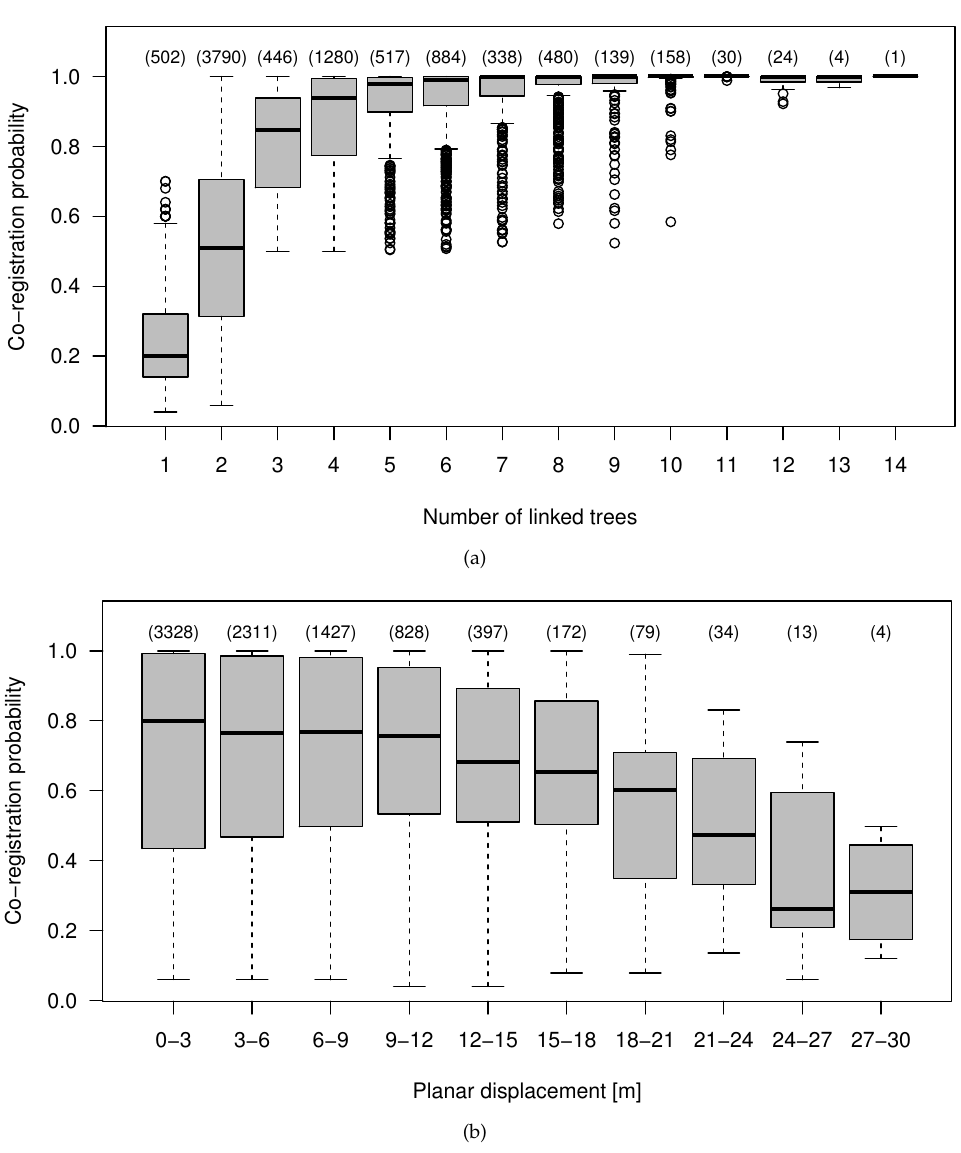
Figure 8. Effect ( a ) of the number of linked trees and ( b ) of the horizontal displacement of the plot center on the co-registration probability. The numbers in brackets correspond to the number of plots. The whiskers extend to 1.5 times the interquartile range. Outliers are marked by